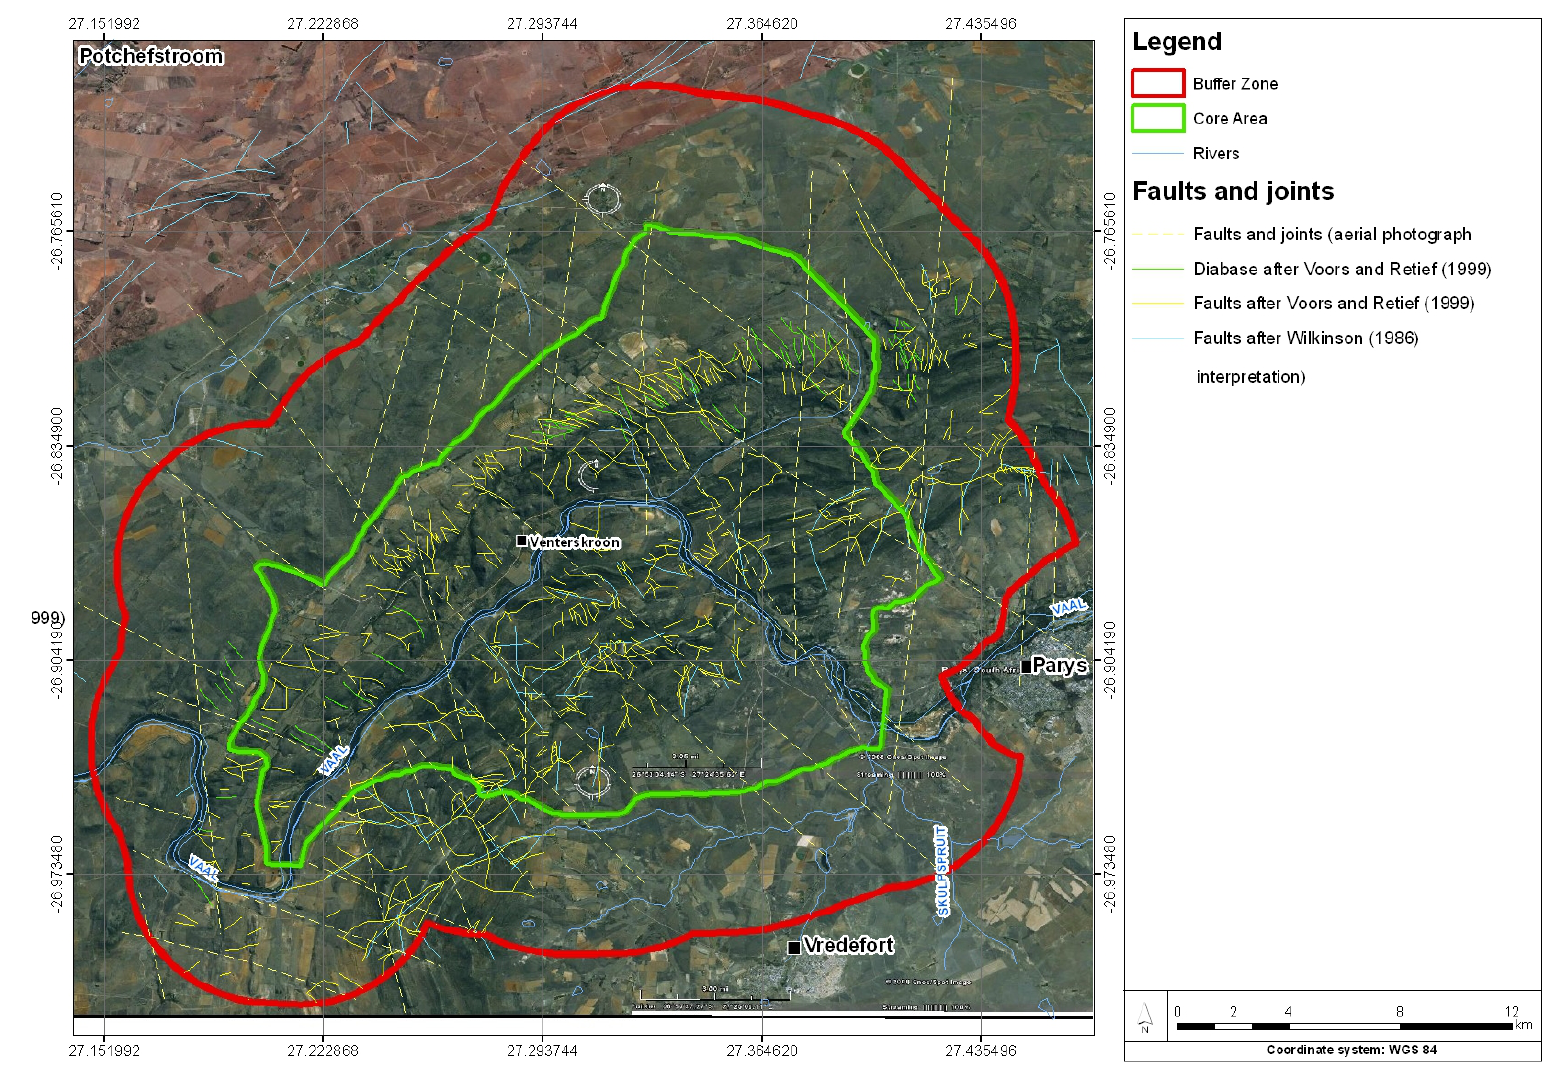
Figure 3. Faults and joints within the